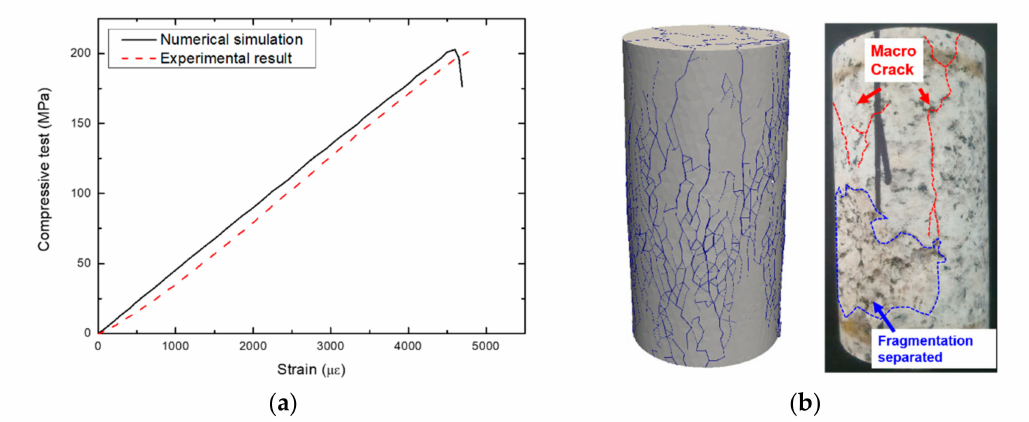
Figure 5. Comparison of FDEM numerical simulation and experiment of the UCS test of granite under quasi-static loading: ( a ) plot of axial stress versus axial strain and ( b ) final fracture pattern from the numerical simulation and experimental test.